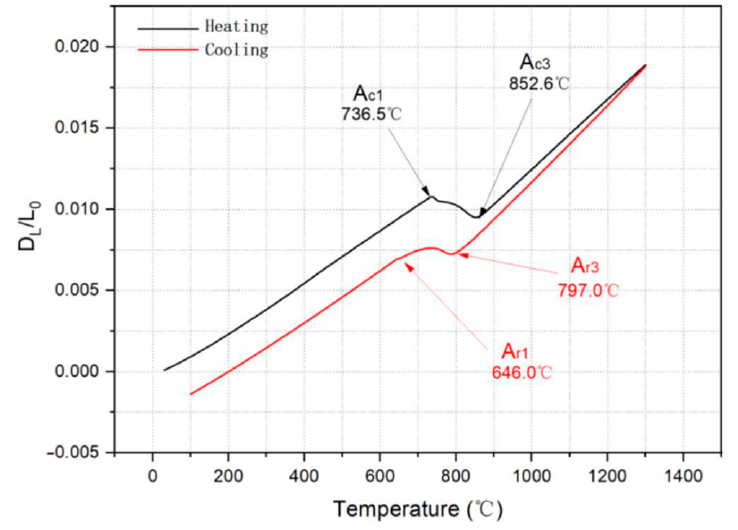
Figure 7. Measured phase transformation temperature of S355 steel.